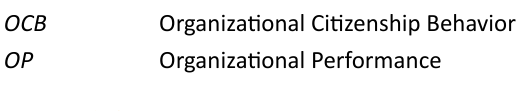
CONFLICT OF INTEREST